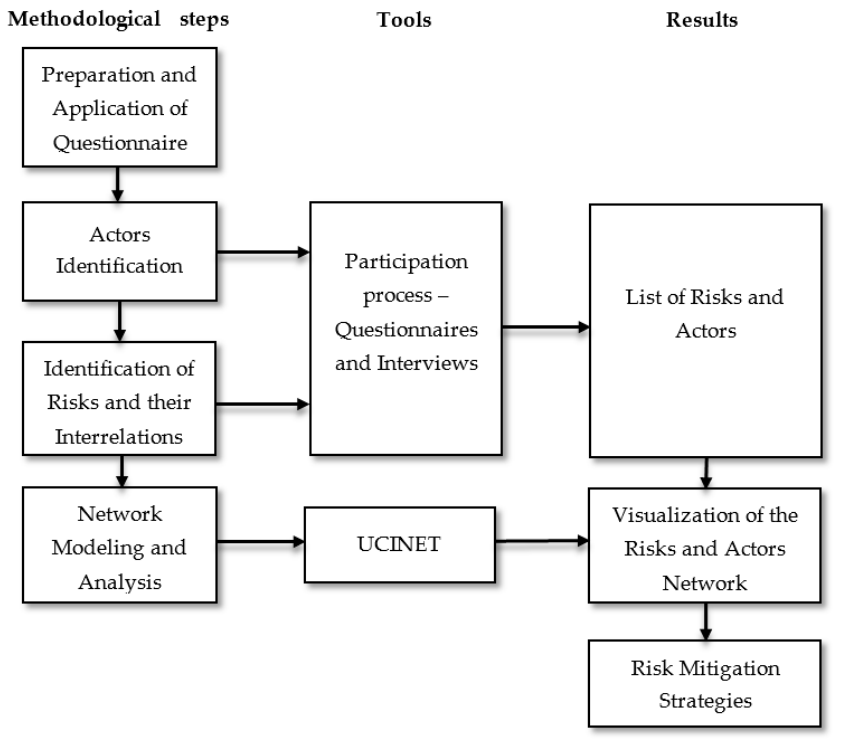
Figure 1. Research process carried out in the case study.